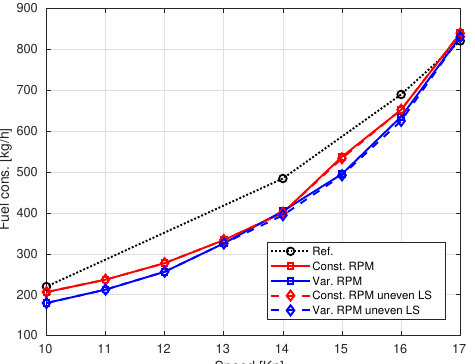
Figure 7. Constant vs. variable revolution speed performance comparison: fuel consumption with even and uneven load sharing.